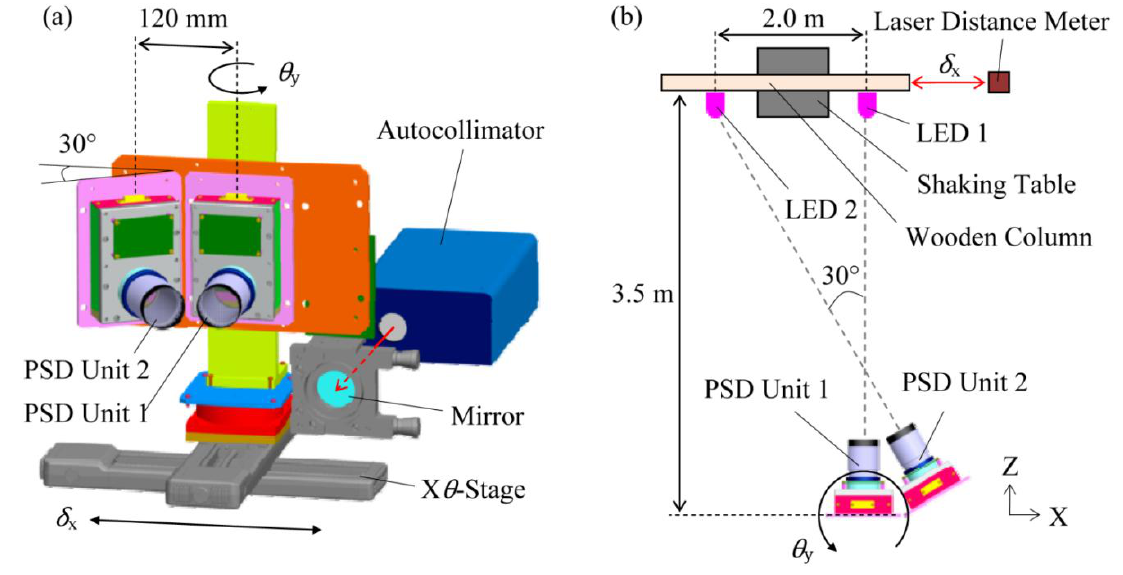
Figure 4. Experimental setup for measuring the relative-story displacement and